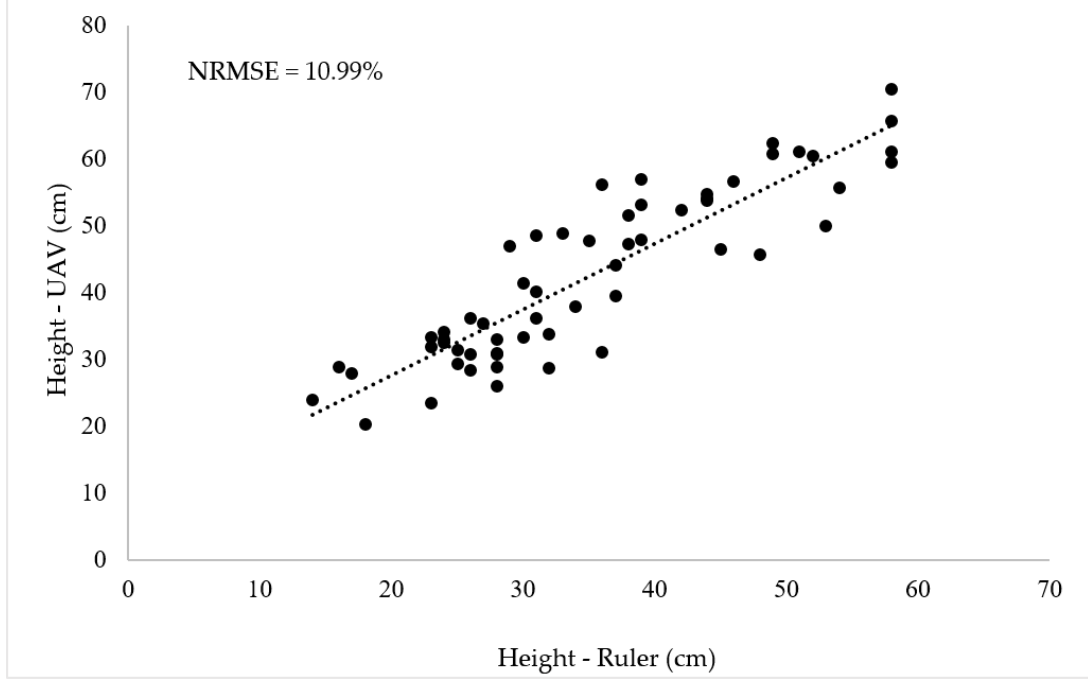
Figure 4. Relationship between the height estimated by the UAV and that measured with the